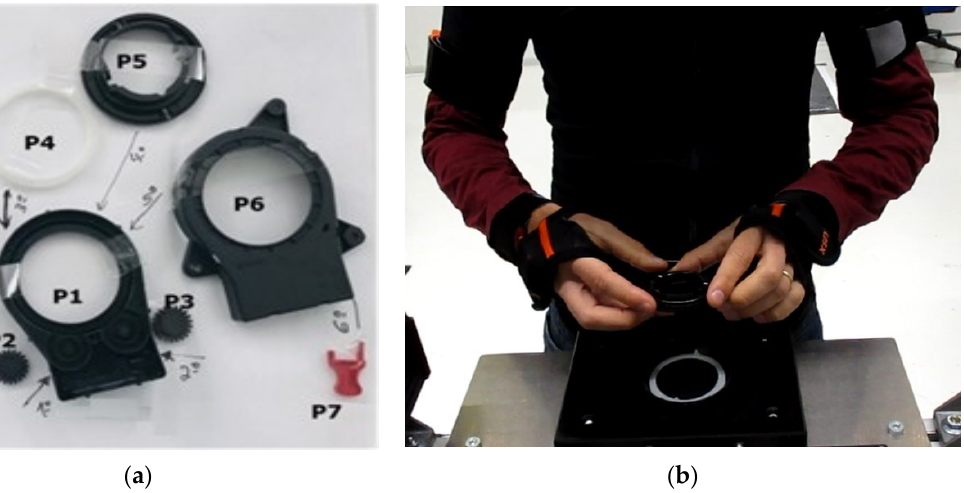
Figure 6. Assembly piece and sequence: ( a ) Components; ( b ) Manual handling.